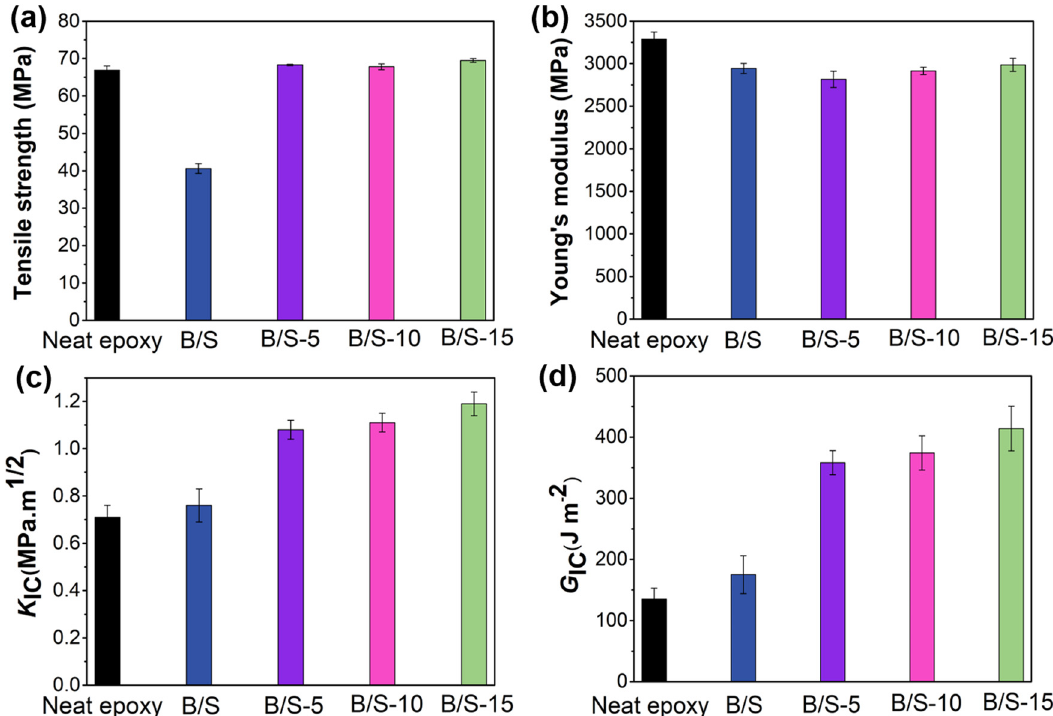
Figure 8: Mechanical properties of cured epoxy resins containing modi fi ed particles. Tensile strengths ( a ) , Young ’ s modulus ( b ) and fracture toughness ( c and d ) .